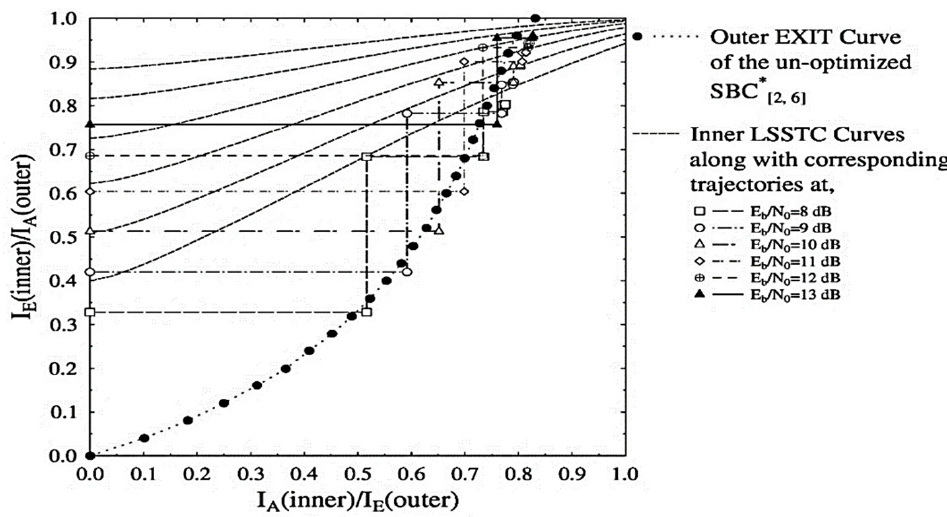
[ 2,6 ] scheme along with Monte-